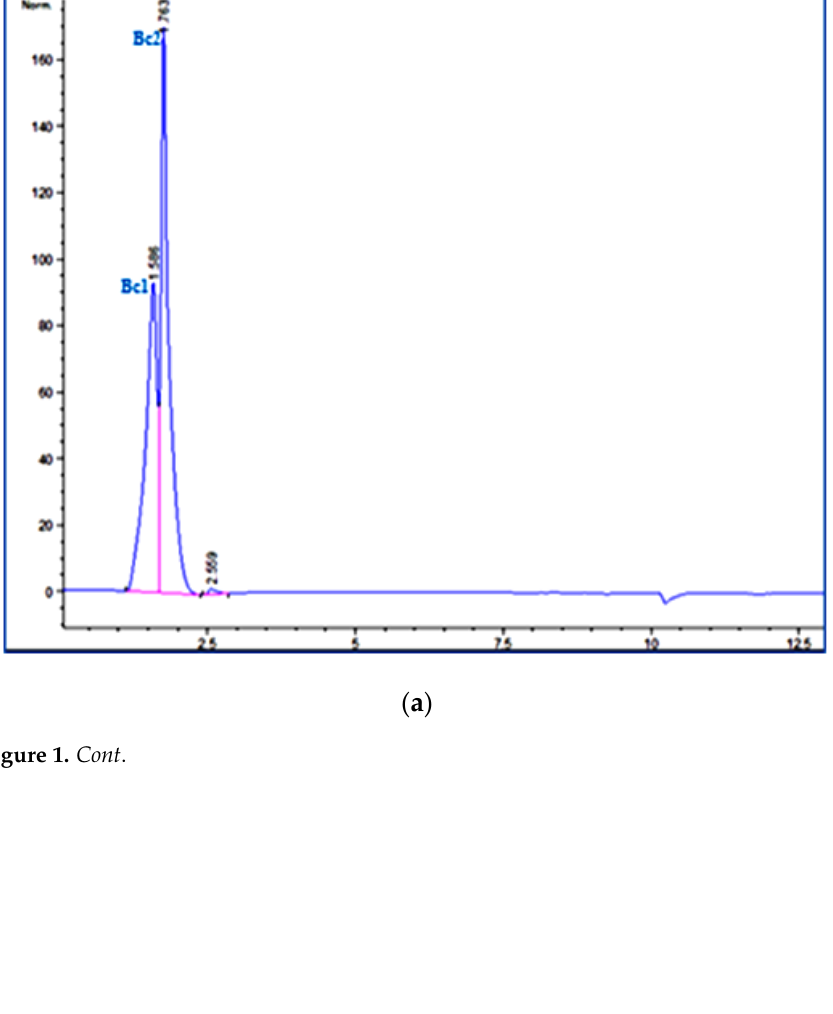
( b ) Figure 1. HPLC chromatograms corresponding to Bcs (( a ) Bc1 and ( b ) Bc2) and Bx of the aqueous extract of beetroot peel (BPE). 3.2. Antibacterial Activity of BPE BPE exhibited antibacterial activity against all studied foodborne pathogens. This extract showed the same MIC (MIC = 2.5 mg/mL) against Gram-positive bacteria (S. au- reus and E. coli ) and Gram-negative bacteria ( S. enterica and L. monocytogenes ). Thus, it was reported that BPE displays an antibacterial property against a wide range of microor- ganisms [40,67]. 3.3. Film Properties